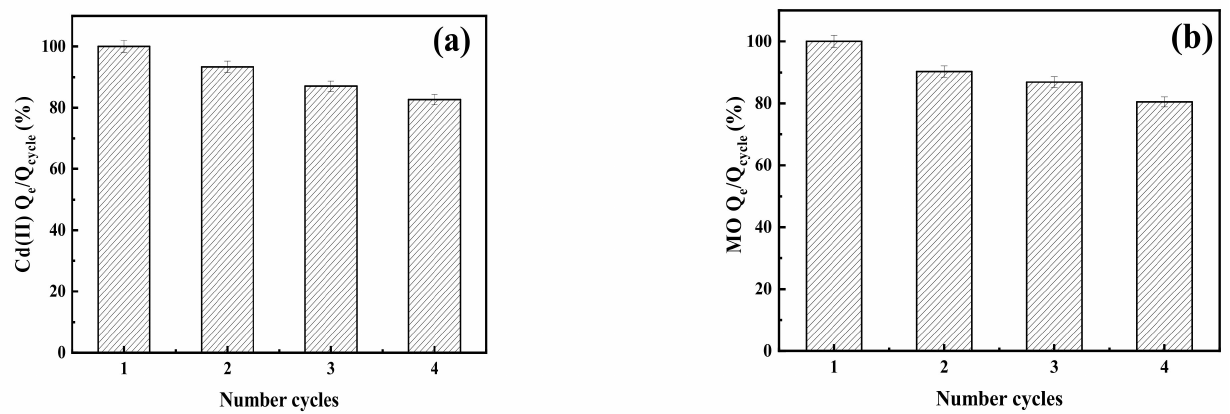
Figure 5. Experiment of desorption–adsorption cycle of BNT-MBC on ( a ) Cd(II) and ( b )